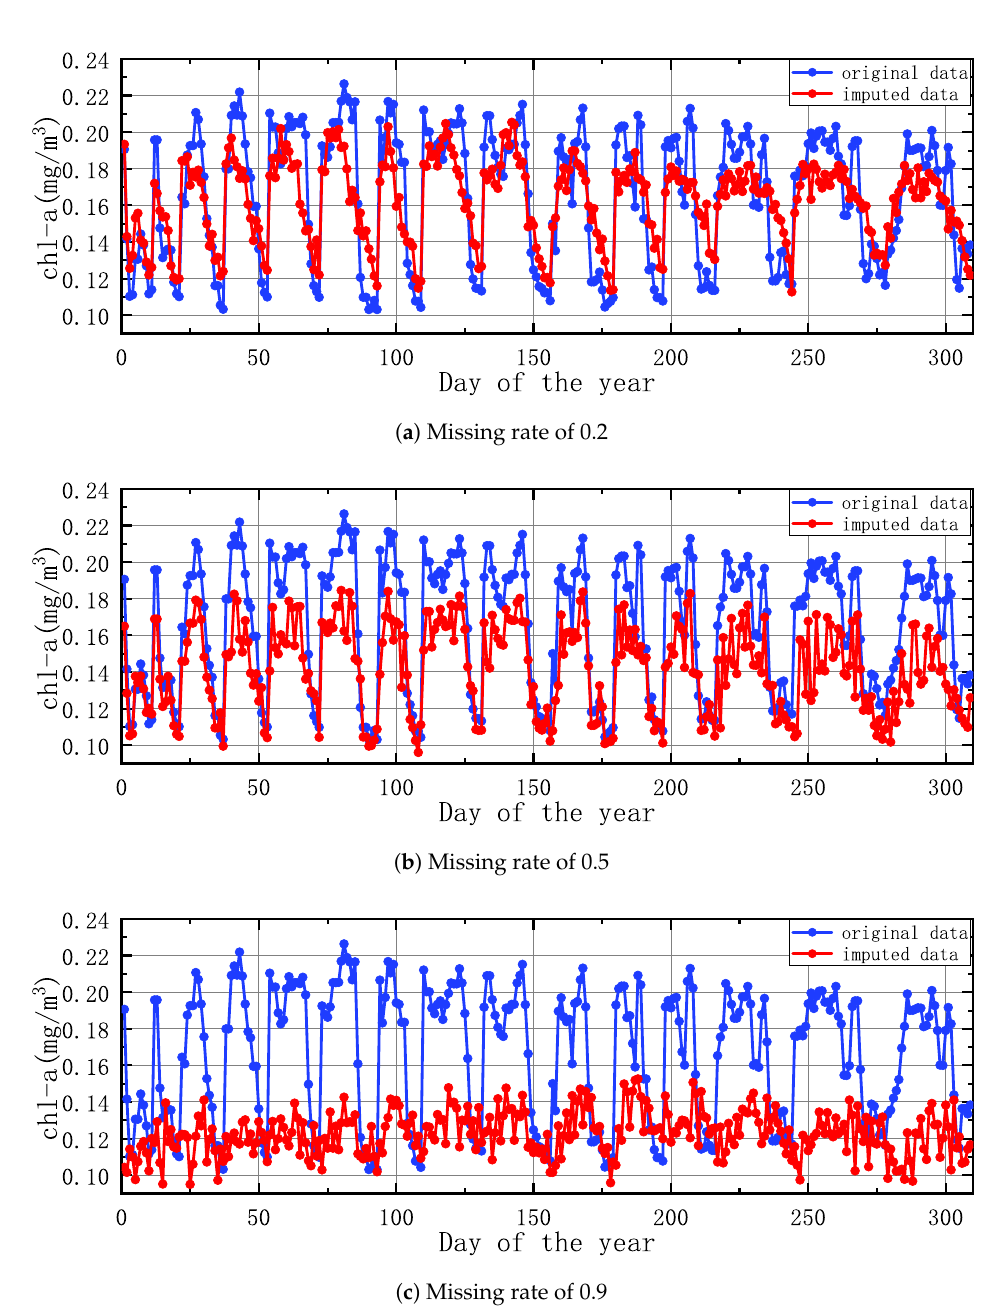
Figure 15. The plotting of the original satellite data and the generated data by STA-GAN model with different missing